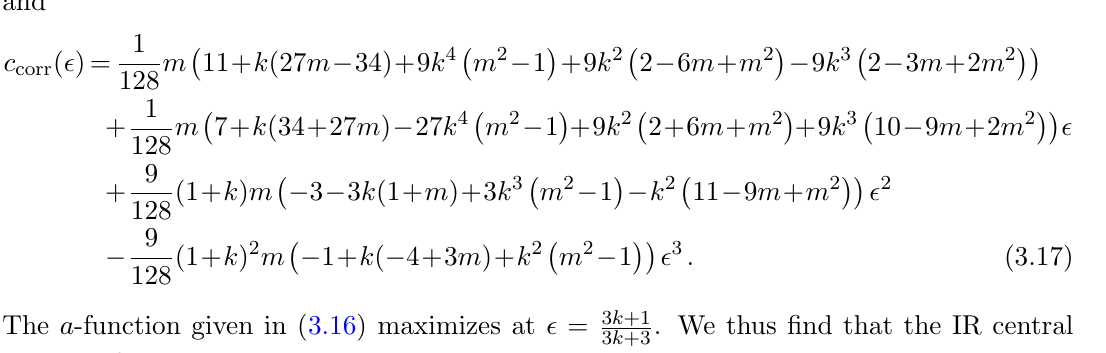
Table 2 . Matter content for the \Lagrangian description" of the ( I m;mk ; S ) theory. Here ‘ runs from 1 to m (cid:0) 2, while the index j in M j runs from 1 to mk . For the sake of brevity, we have not included the (cid:13)avor symmetries acting on the various bifundamental hypermultiplets.